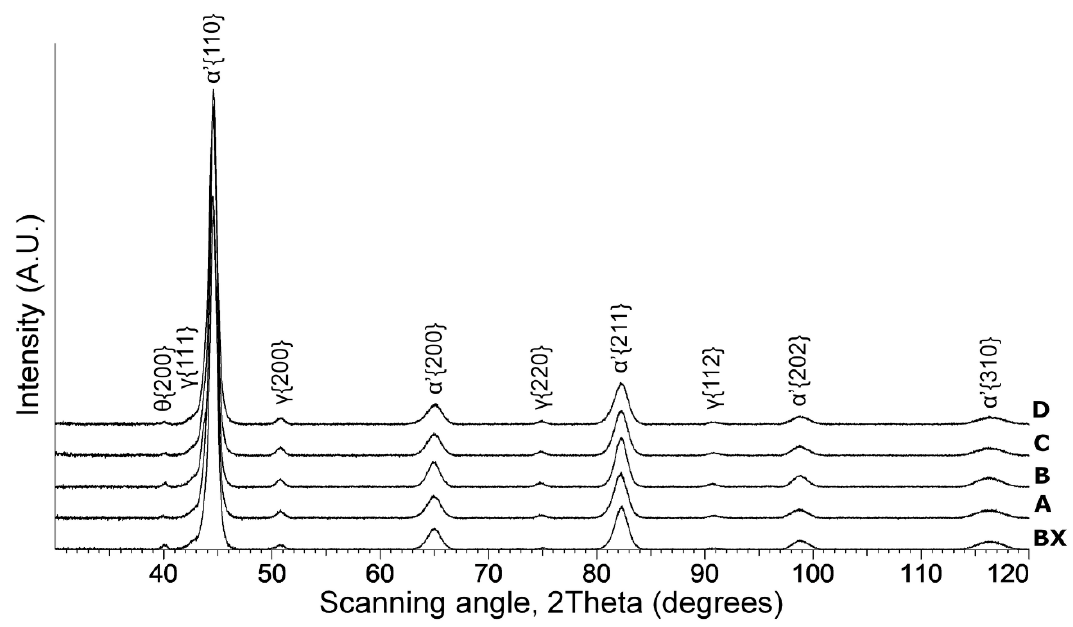
Figure 1. XRD patterns of the medium carbon steels with various contents of silicon and copper after quenching.